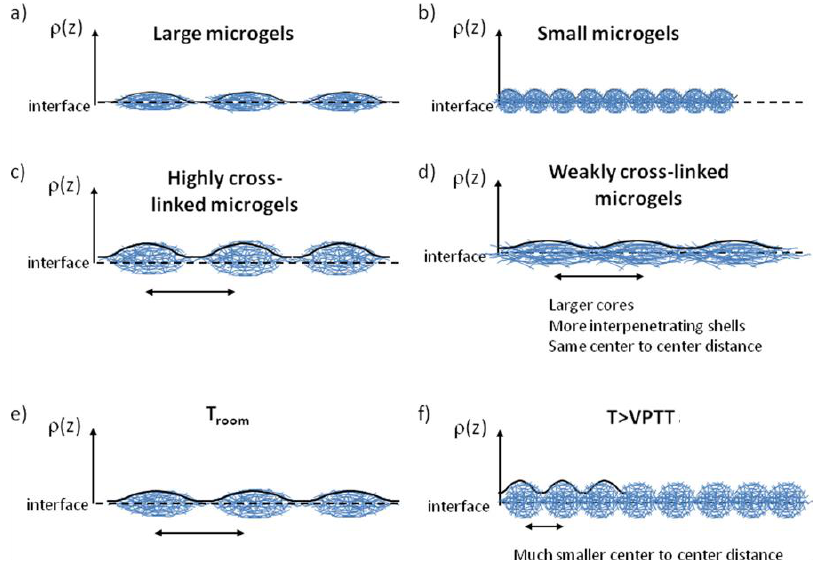
Figure 7. Effect of the different parameters affecting the emulsion properties on the organization of microgel-laden interfaces. ( a , b ) Microgel size. ( c , d ) Cross-linking density. ( e , f ) Processing temperature (VPTT: volume phase transition temperature). Adapted from Destribats et al. [85] with permission from the American Chemical Society, Copyright (2014).